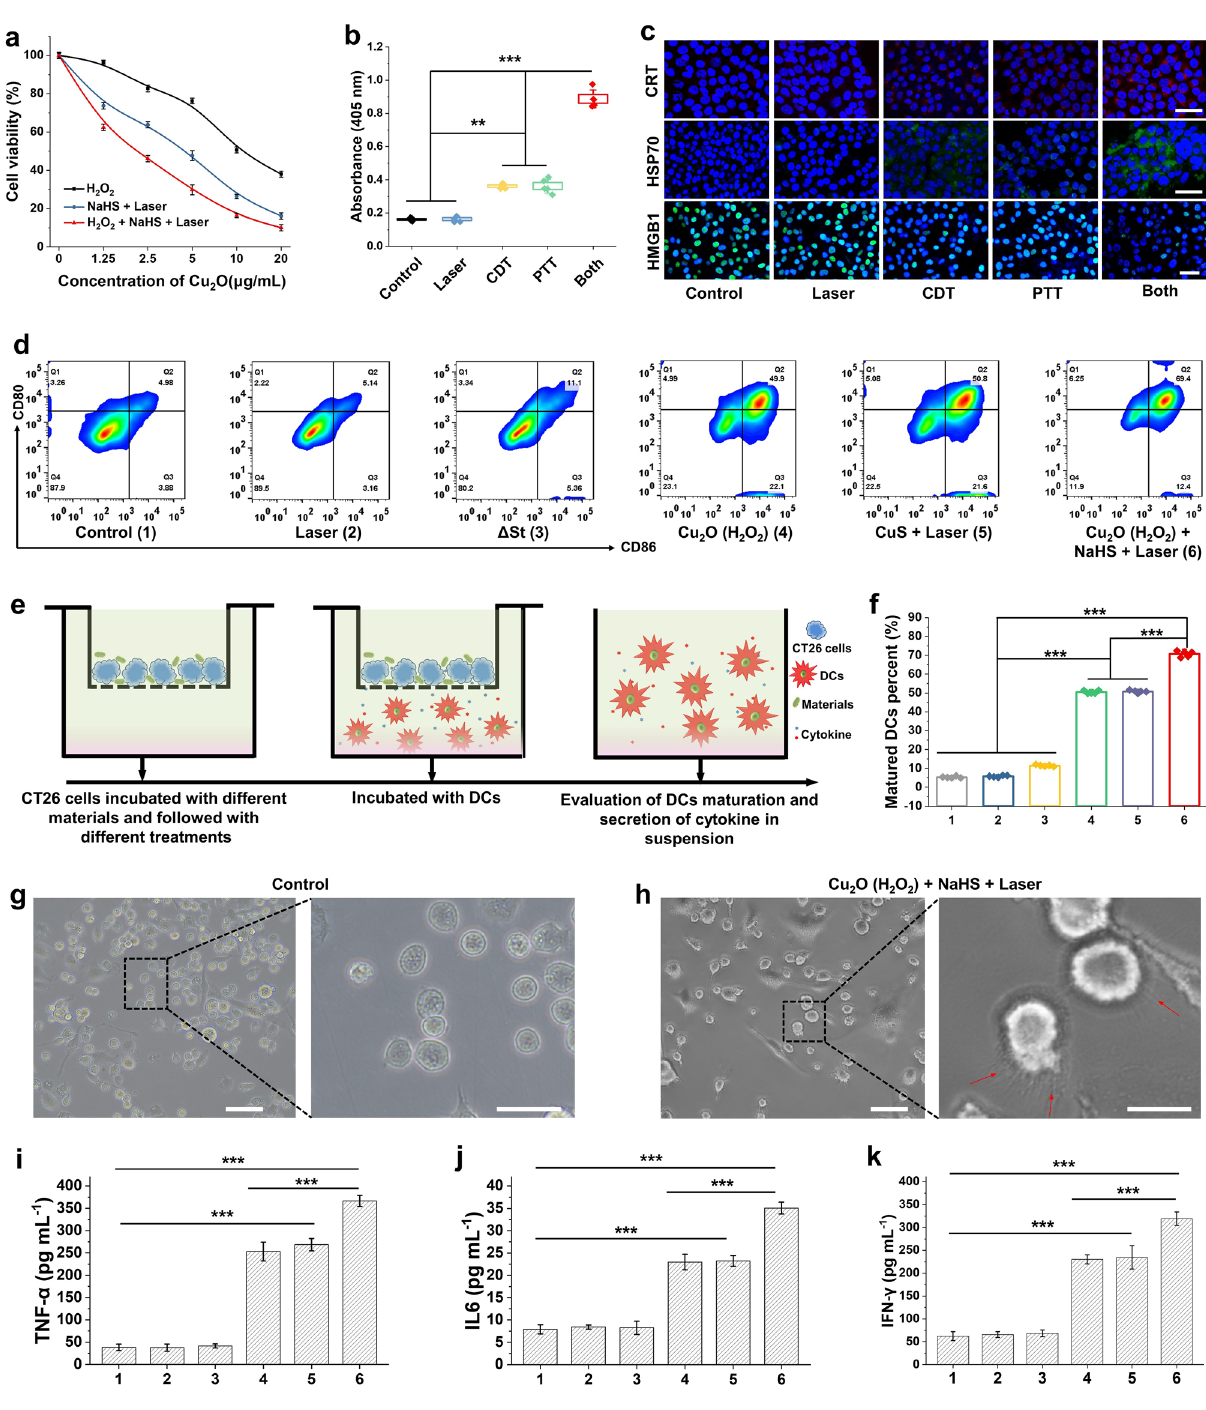
Fig. 3 Cytotoxic and in vitro DCs maturation study. a Viability of CT26 cells after different treatments. b Caspase-3 activity in CT26 cells after different treatments ( n = 6, mean ± standard error). c Immunofluorescence images of CRT, HSP70, and HMGB1 of CT26 cells received different treatments (scale bar, 50 μm). d Flow cytometry results of DCs after different treatments in the transwell system. e Schematic illustration of the transwell system experiment. DCs were cultured in the lower chamber, while pretreated CT26 cells were placed in the upper chamber. f Quan- tifications of the percentages of mature DCs (CD11c + CD80 + CD86. + ) ( n = 5, mean ± standard error). g, h Photo-microscopy image of DCs after different treatments, scale bar: left, 100 μm; right, 40 μm. i, k Levels of TNF-α, IL6, and IFN-γ in DCs suspensions which were measured by ELISA ( n = 5, mean ± standard